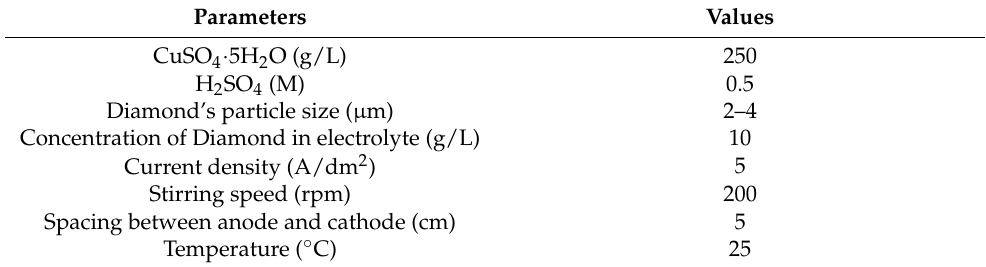
Table 1. Parameters of the electrolyte solution and the composite electrodeposition process.